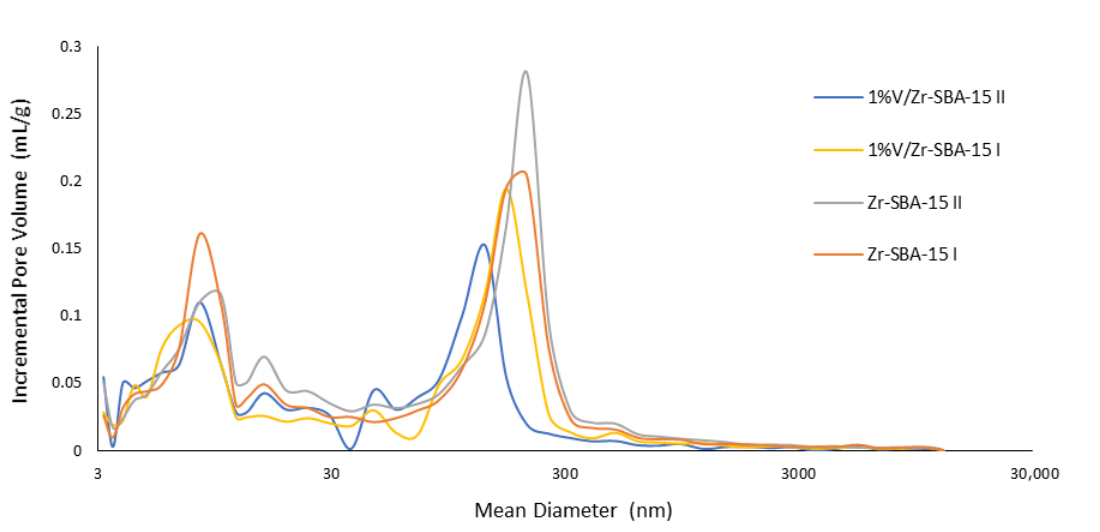
Figure 5. Mercury porosimetry analyses. Pore diameter and pore volume with a given diameter for the used catalysts.